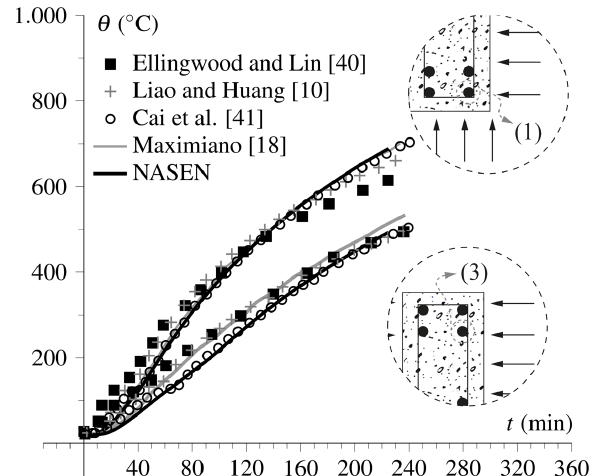
Figure 5. Temperature evolution in the top (3) and bottom (1) steel bars contained in the cross section of the reinforced concrete